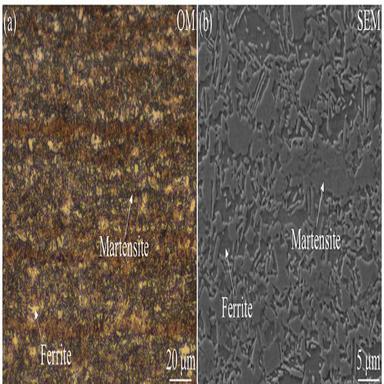
Microstructure of the advanced high strength steel: (a) metallographical image, (b) SEM image.